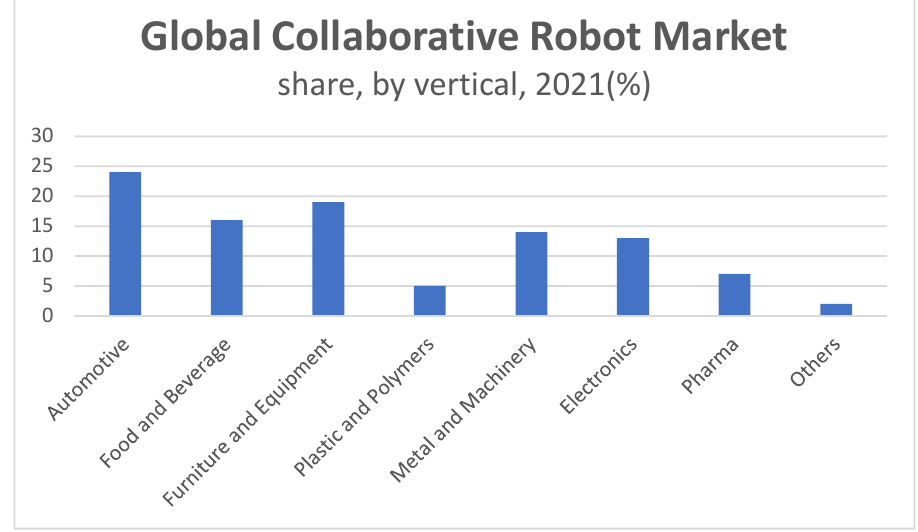
Figure 1. Global collaborative robot market in 2021.